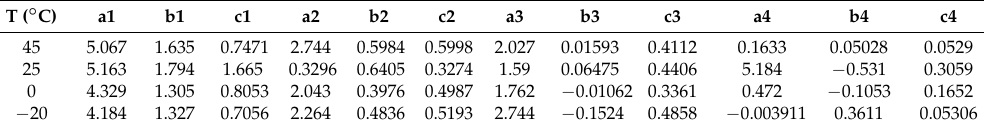
Table 6. The coefficient value of OCV-SOC Gaussian model (n = 4) fitting under different temperatures.